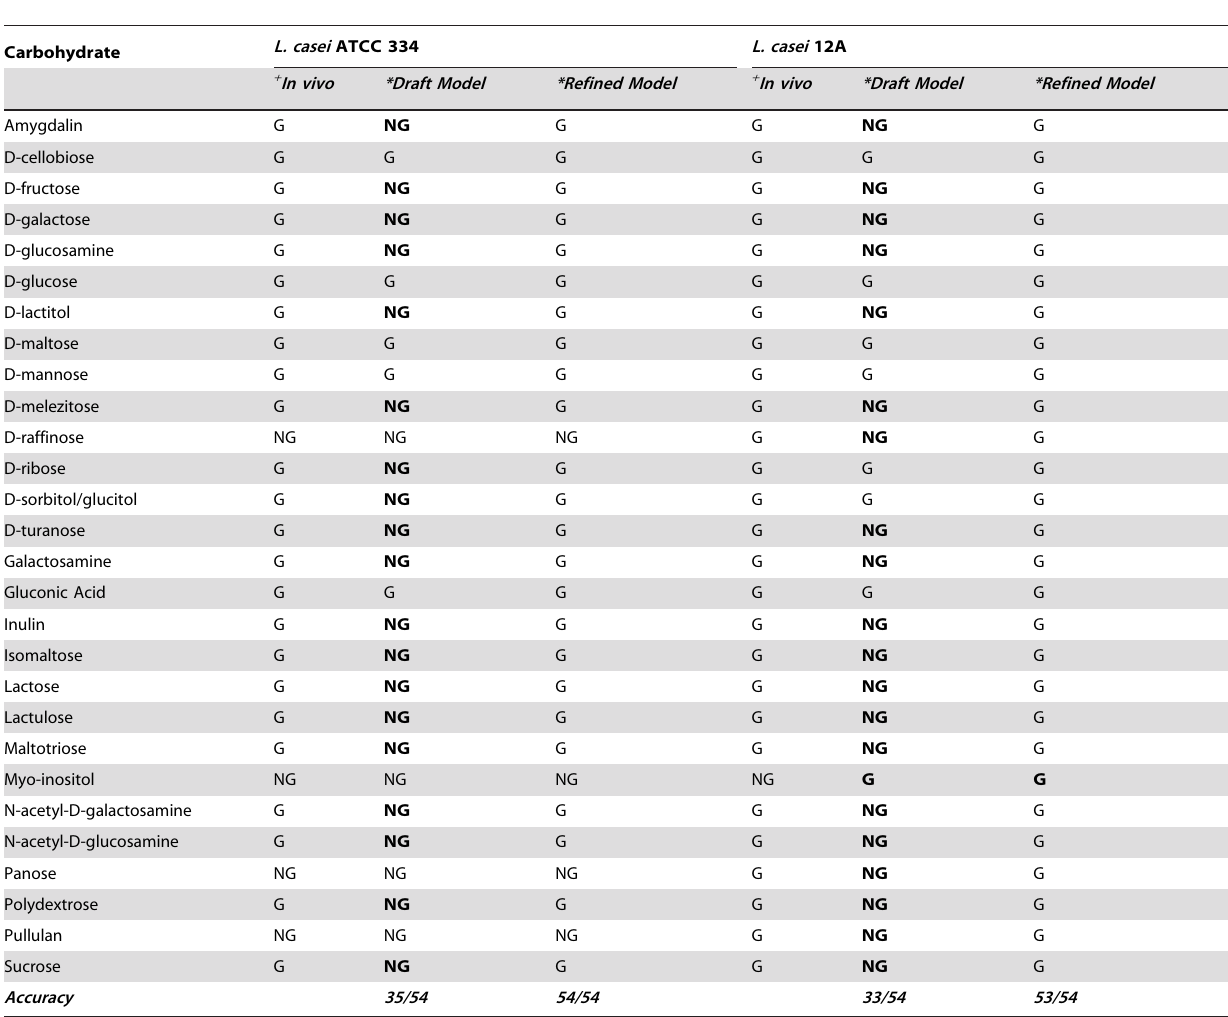
Table 4. Carbohydrate utilization of L. casei ATCC 334 and 12A as determined by in vivo experiments and flux balance analysis of the models prior to and after model refinement.